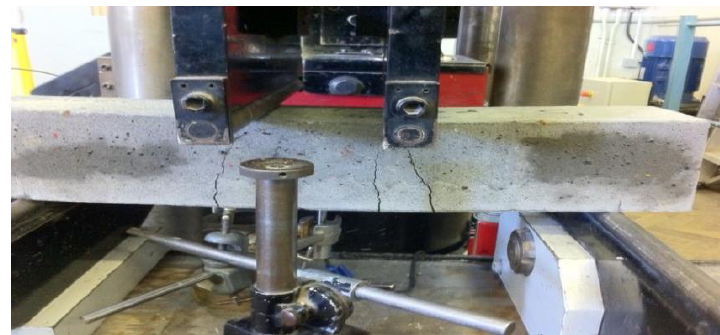
Figure 21. Comparison between mid-span load-deflection uni-axial tow TRC and SRC beams of the same area.